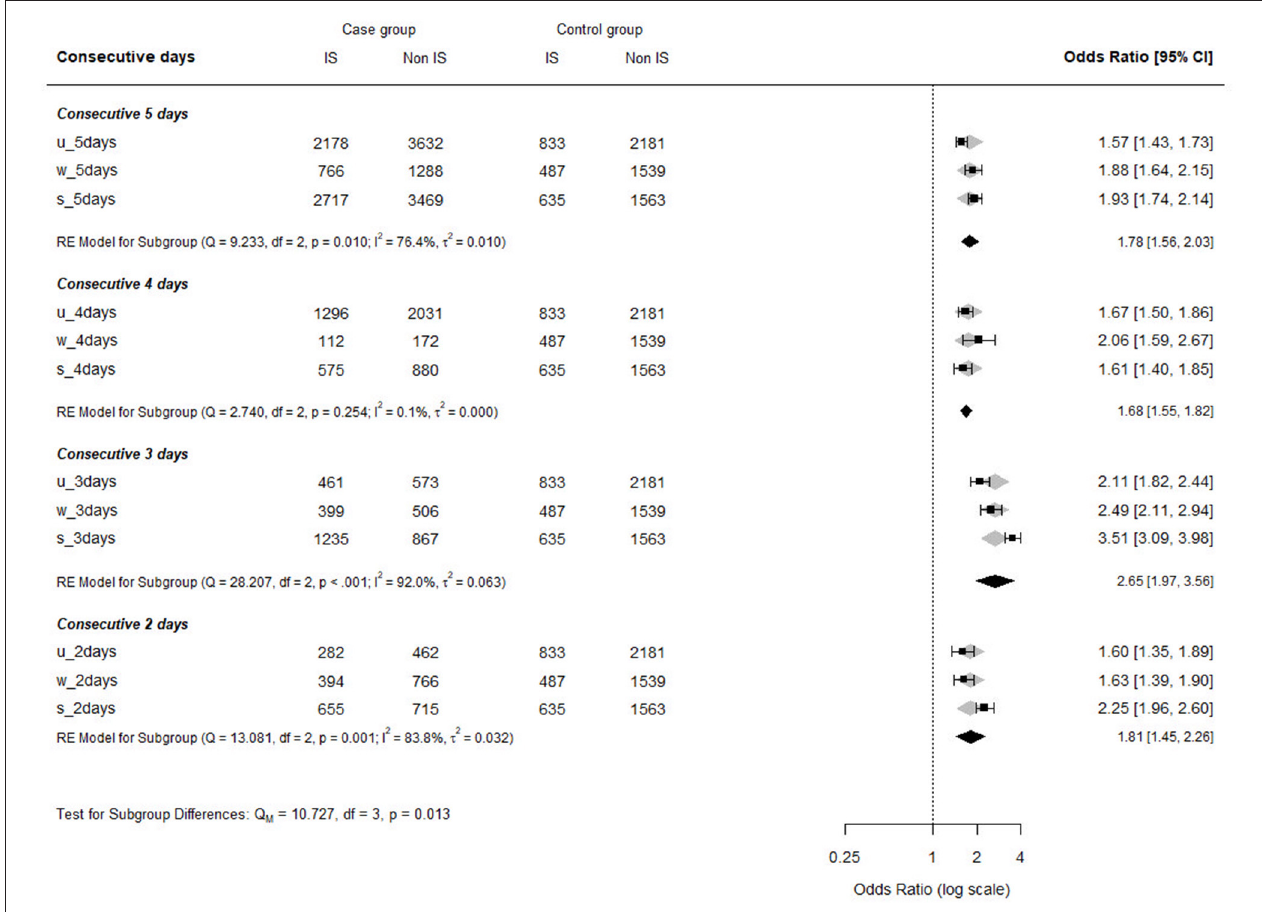
FIGURE 1 | Odds ratios for prevalence of insomnia by consecutive night shift in each institution. IS, insomnia; u, Ulsan University; s, Severance; w, Wonju Severance.